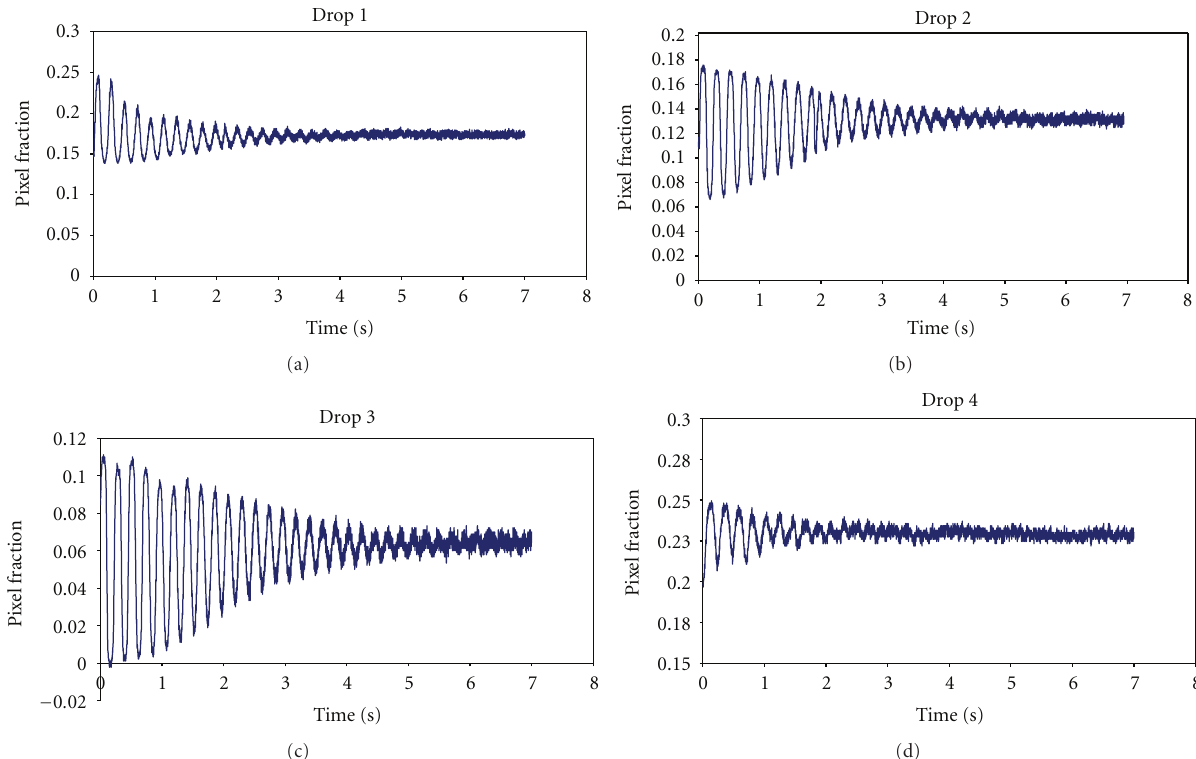
Figure 3: The graphs show the underdamped decay attained for the fraction of the i -pixel occupied by the beam used for the four Montagnole drops.